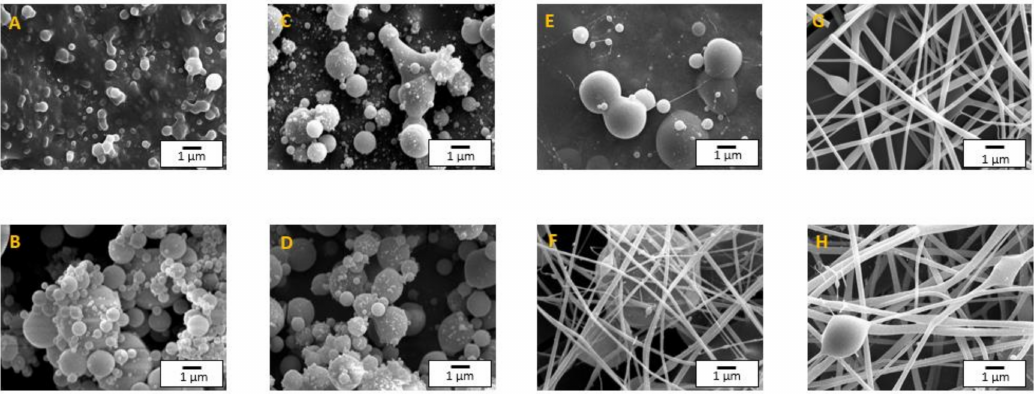
Figure 5. SEM electrospun nanostructures obtained at different EKL:PVP ratios. ( A ) EKL100 at 30 wt.%., ( B ) EKL100 at 40 wt.%., ( C ) EKL99-PVP1 at 30 wt.%., ( D ) EKL99-PVP1 at 40 wt.%., ( E ) EKL97-PVP3 at 30 wt.%., ( F ) EKL97-PVP3 at 40 wt.%., ( G ) EKL95-PVP5 at 30 wt.% and ( H ) EKL95-PVP5 at 40